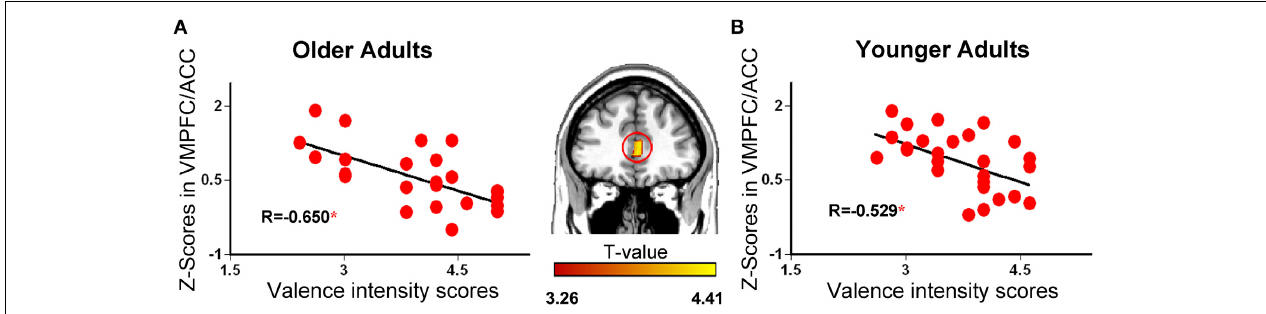
FIGURE 6 | Mean responses in the ventromedial prefrontal cortex (VMPFC) correlated significantly with the valence intensity of the retrieved autobiographical events in the older (A) and younger (B) groups for positive and negative memories, respectively. The